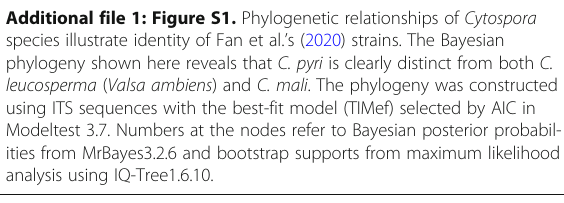
Additional file 1: Figure S1. Phylogenetic relationships of Cytospora species illustrate identity of Fan et al. ’ s (2020) strains. The Bayesian phylogeny shown here reveals that C. pyri is clearly distinct from both C. leucosperma ( Valsa ambiens ) and C. mali . The phylogeny was constructed using ITS sequences with the best-fit model (TIMef) selected by AIC in Modeltest 3.7. Numbers at the nodes refer to Bayesian posterior probabil- ities from MrBayes3.2.6 and bootstrap supports from maximum likelihood analysis using